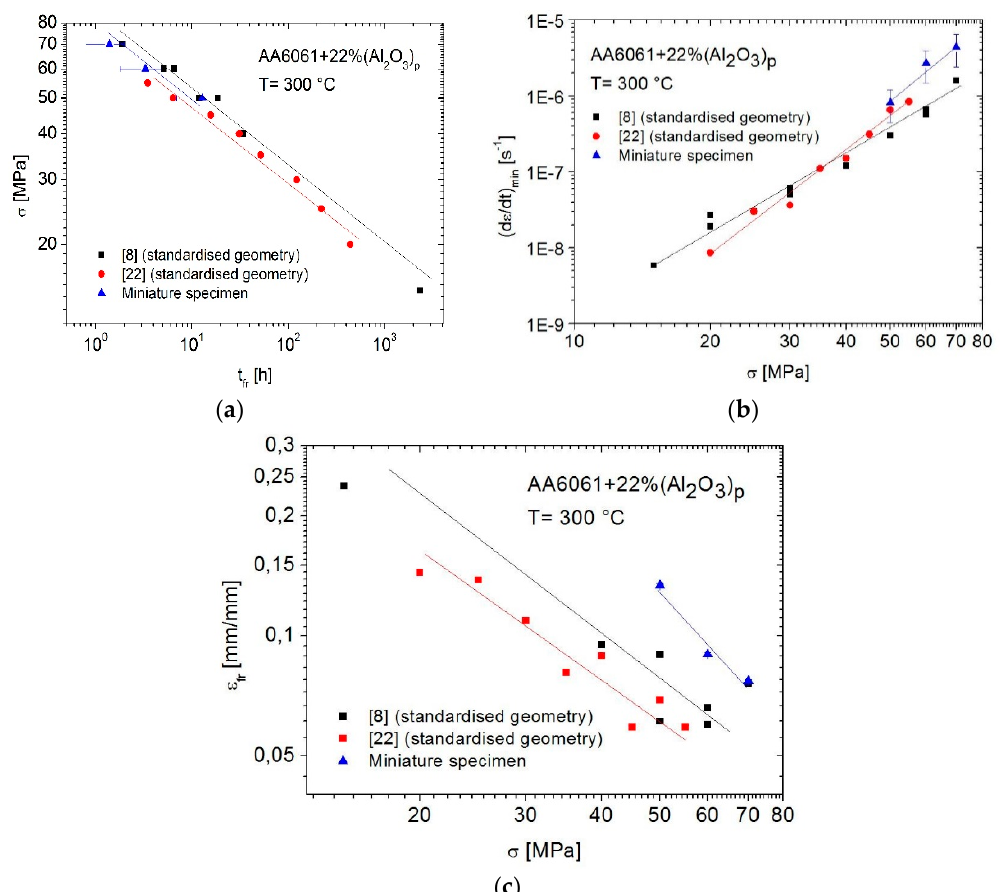
Figure 14. Creep parameter: ( a ) creep diagram; ( b ) Norton-diagram; ( c ) strain at creep fracture.